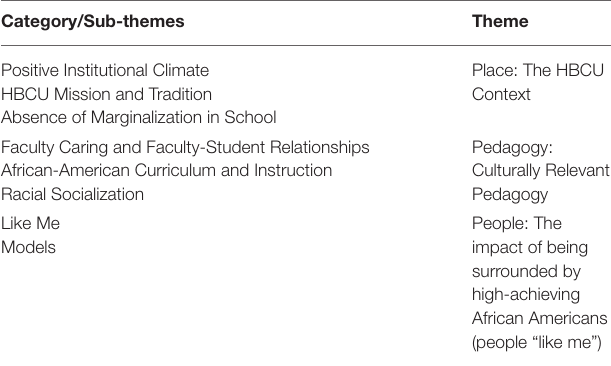
TABLE 1 | Themes and subthemes in how the HBCU Shapes Students’ Academic